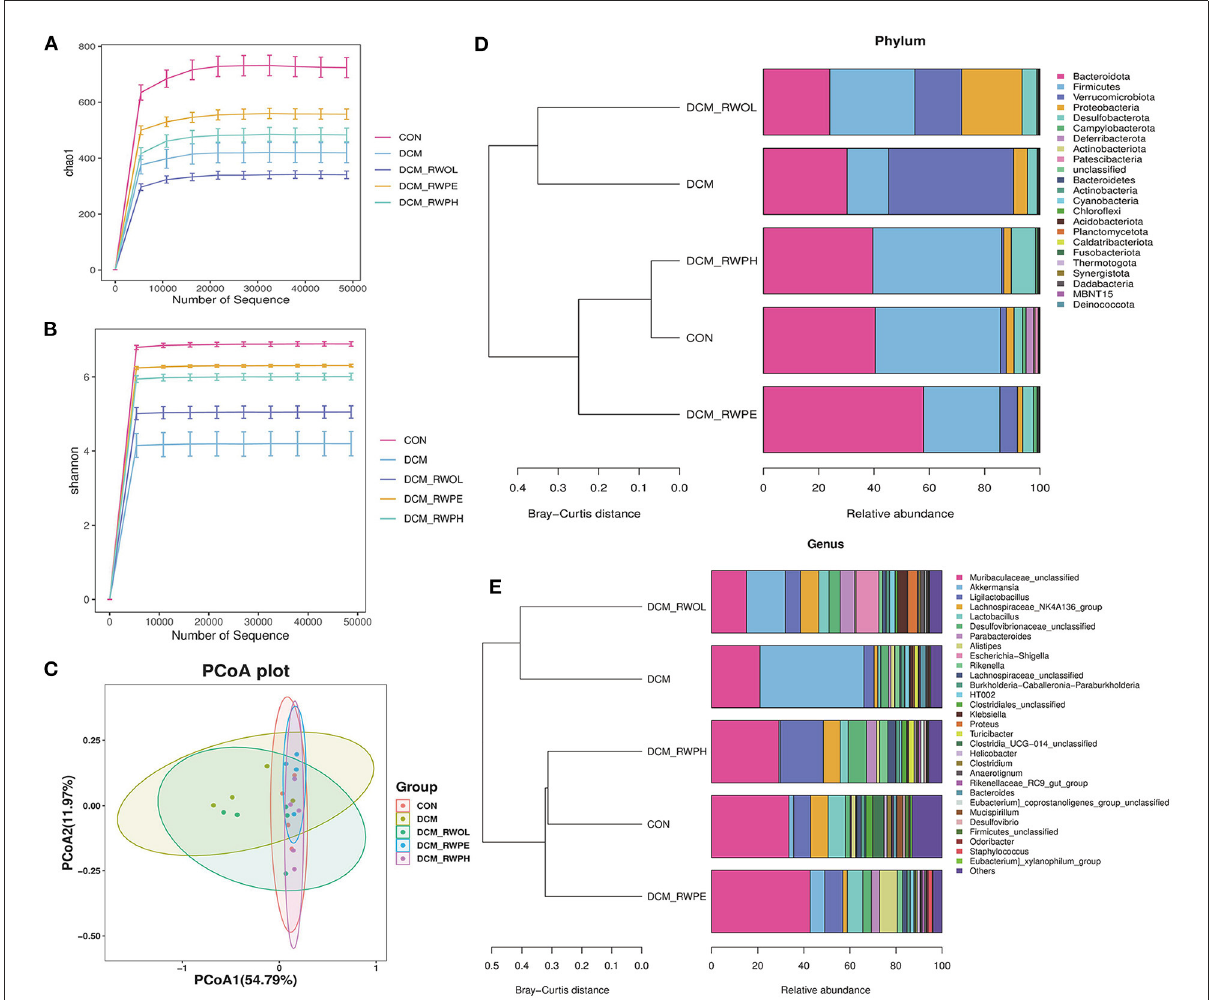
FIGURE6 RWPH and RWPE prevented gut microbiota dysbiosis in DCM mice (n = 4 per group). (A,B) The Chao1 and Shannon diversity index of intestinal bacteria was examined by 16S-rRNA high-throughput sequencing. (C) The β -diversity of intestinal bacteria was compared by the weighted unifrac principal coordinates analysis (PCoA). (D) At the phylum level, the Bray-Curtis distance clustering tree and the relative abundance of the gut bacterial in each group. (E) At the genus level, the Bray-Curits distance clustering tree and the relative abundance of the gut bacterial in each